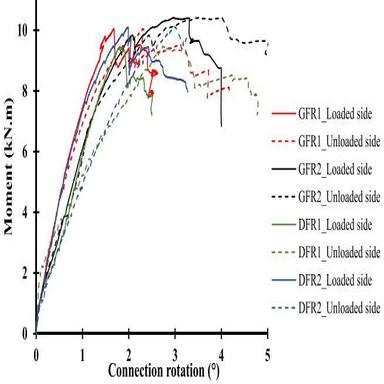
Moment rotation behaviour of localised connections of loaded and unloaded sides within both frame types.